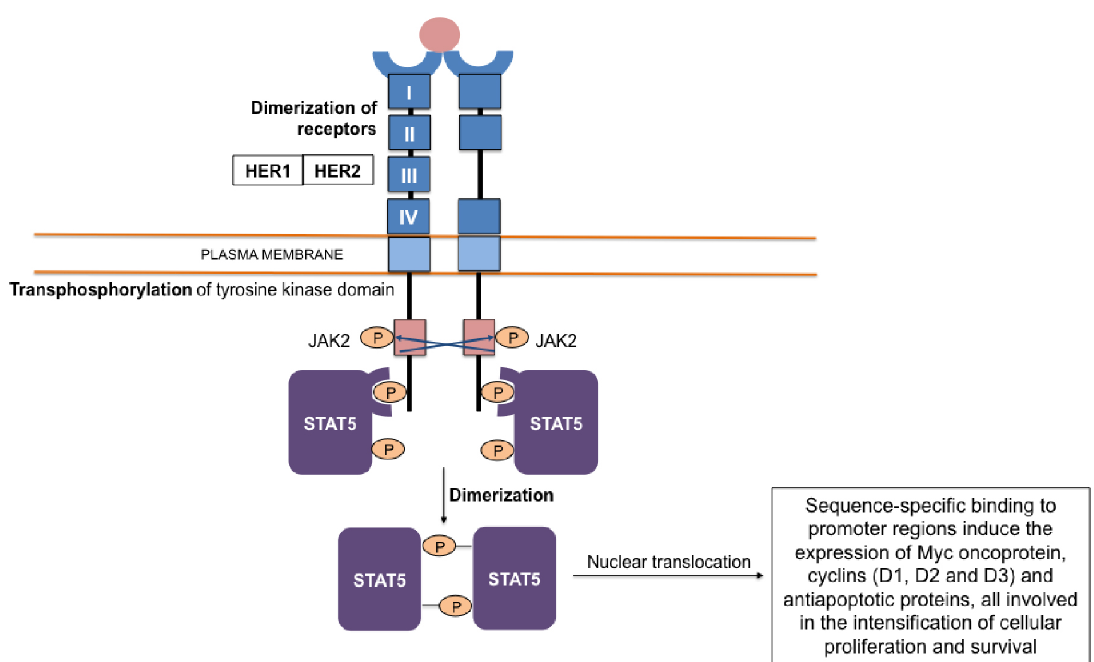
FIGURE 3 - Signaling activation of JAK/STAT pathway by human epidermal receptors (HER). STAT-STAT dimerization may occur between identical or different dimers (e.g., STAT1/STAT2 or